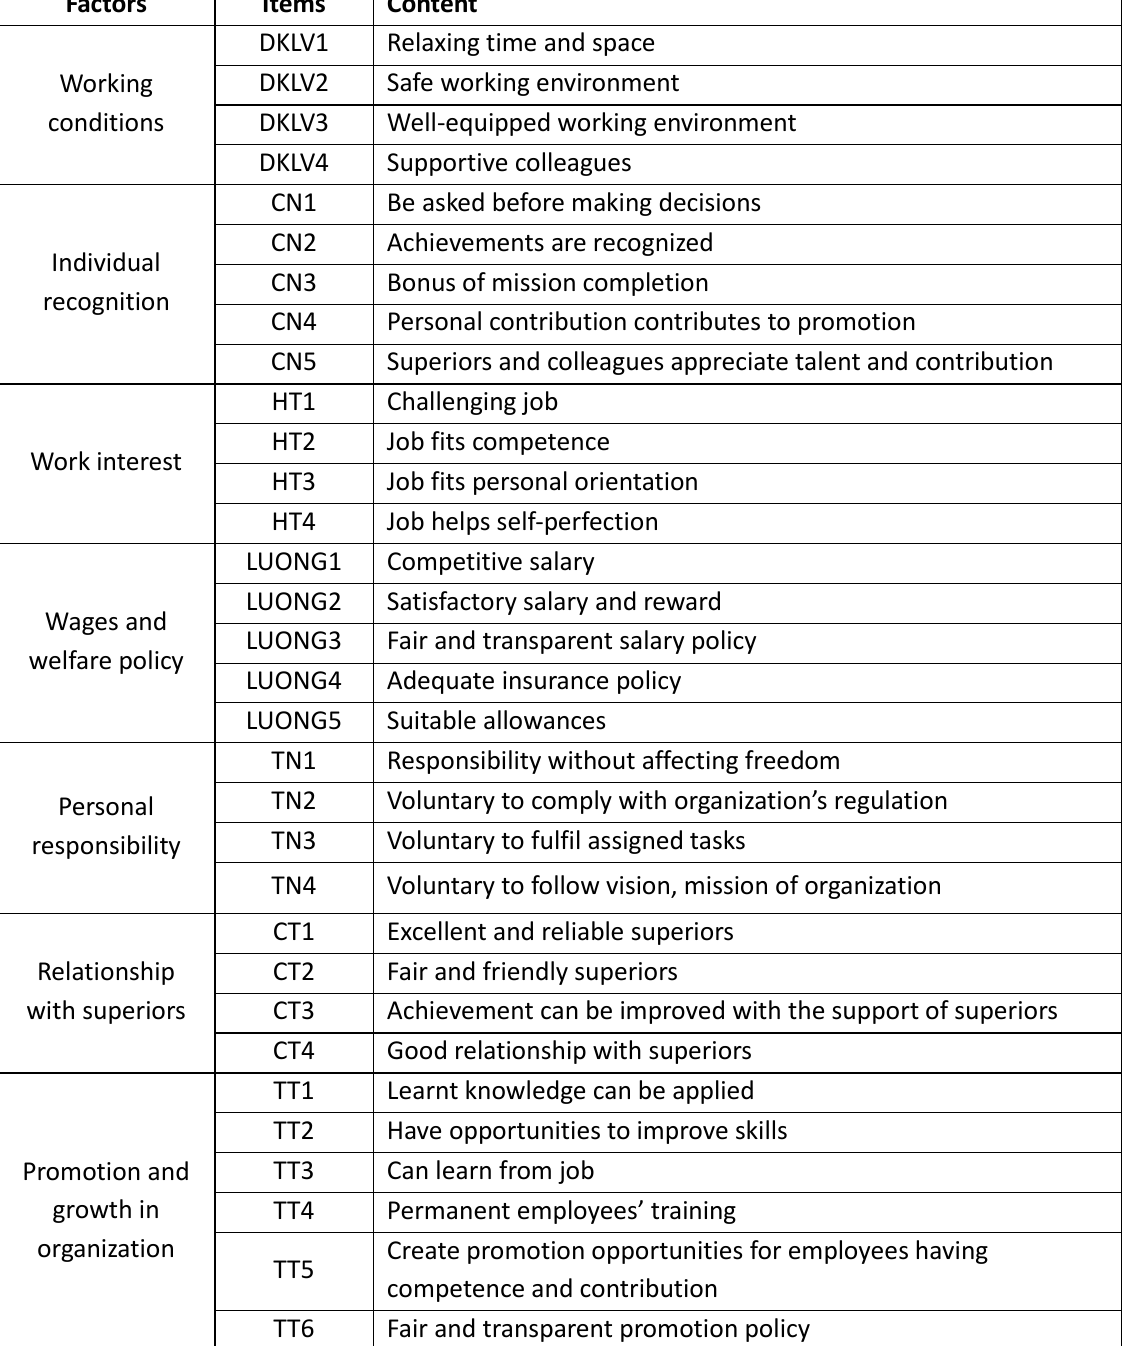
Table 1. Concepts’